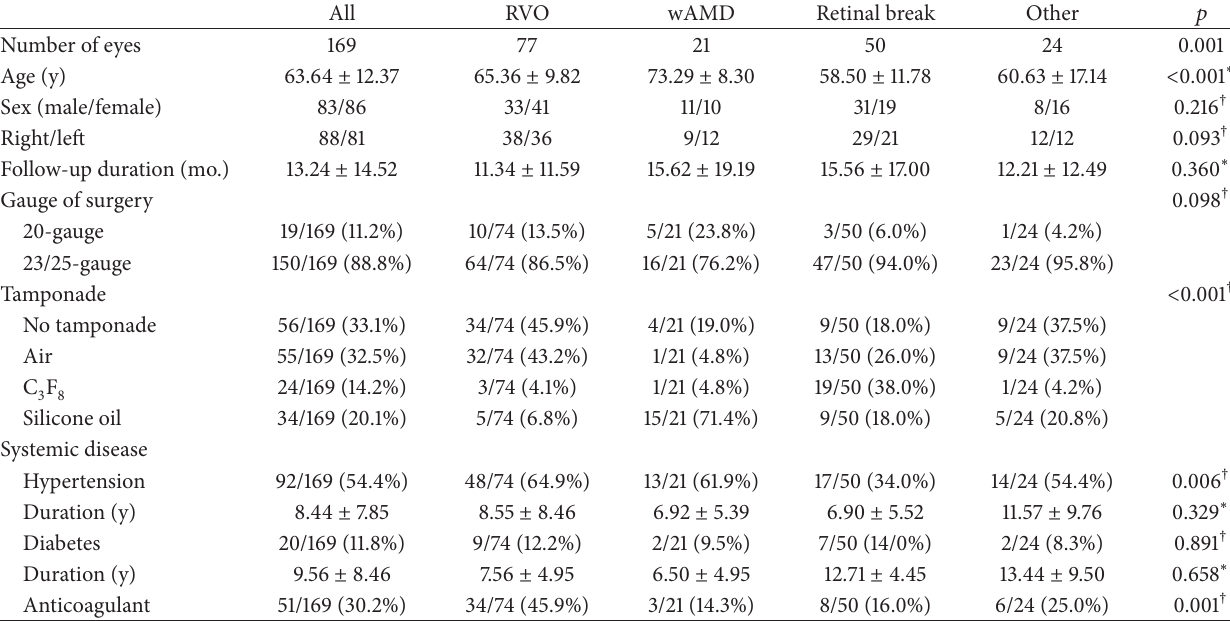
Table 2: Clinical characteristics of acute-onset vitreous hemorrhage (VH) of preoperatively unknown origin.